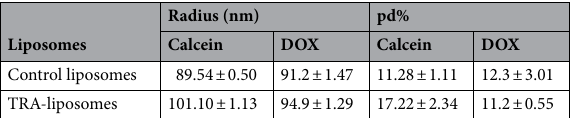
Table 1. Size and polydispersity of Calcein and DOX-loaded control and immunoliposomes.